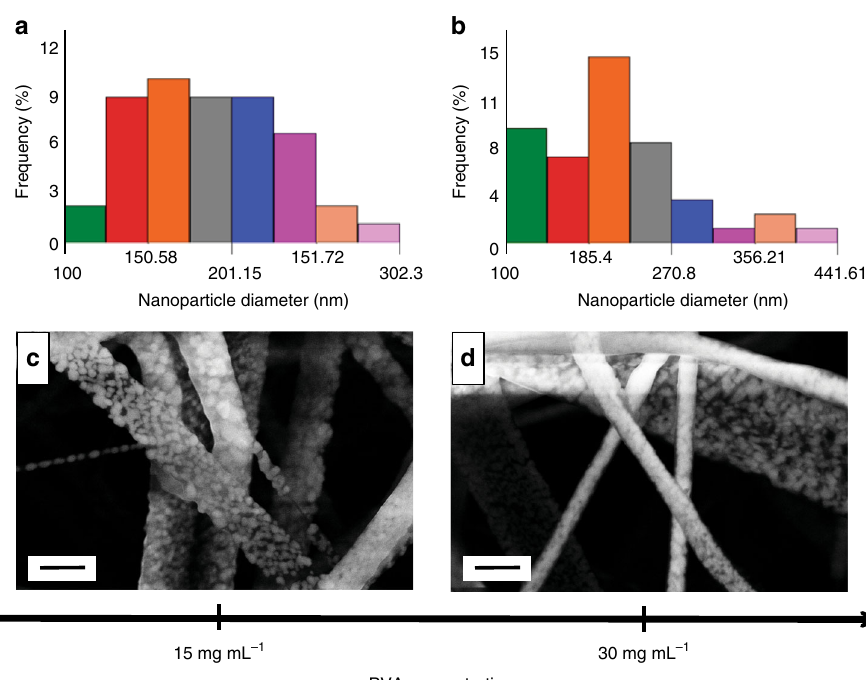
Fig. 5 Scanning electron microscope images with corresponding histograms. The images show the as-spun nanoparticle-decorated caesium dihydrogen phosphate (CDP)-polyvinyl alcohol (PVA)-polyaniline (PANI) samples as a function of PVA concentration. a Histogram showing the size distribution for the sample from 15 mg mL − 1 PVA concentration. The mean nanoparticle size is 188.5 ± 43 nm. b Histogram showing the size distribution for the sample from the 30 mg mL − 1 PVA solution. The mean nanoparticle size is 218 ± 69 nm. c Scanning electron microscopy (SEM) image of the sample from 15 mg mL − 1 PVA solution. The nanoparticle density is 28 particles µ m − 2 . d Scanning electron microscope image of the sample produced from the